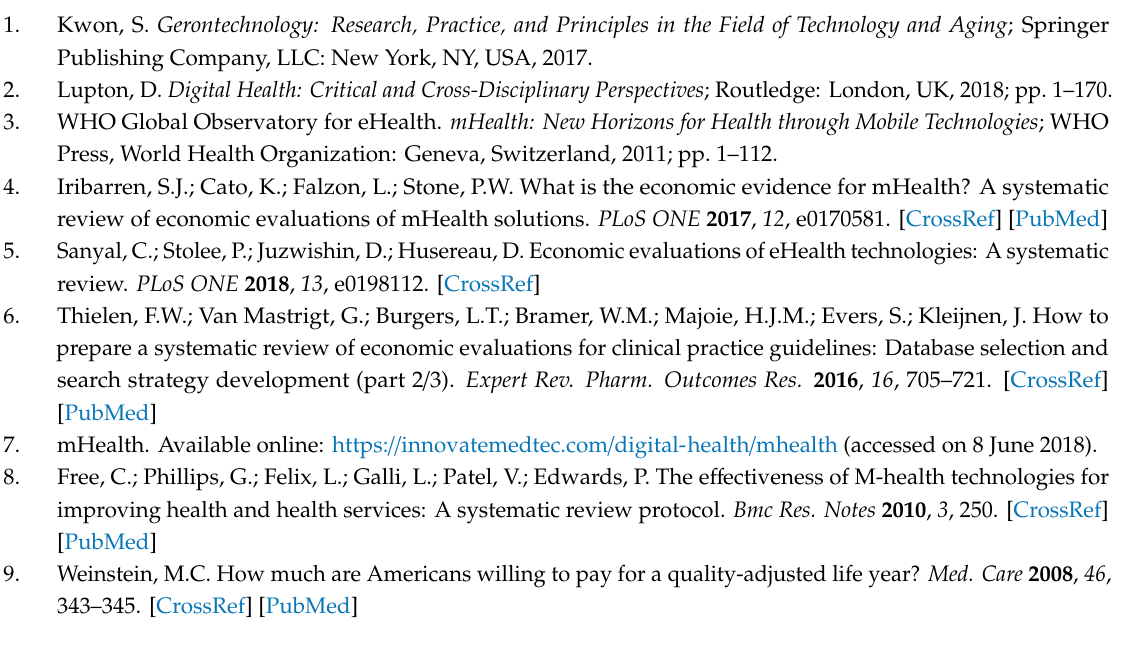
Table S1: Key words, Table S2: Characteristics of complex smartphone communication studies, Table S3: Characteristics of simple text-based communication studies, Table S4: Details of cost and e ff ectiveness measure of complex smartphone communication studies, Table S5: Details of cost and e ff ectiveness measure of simple text-based communication